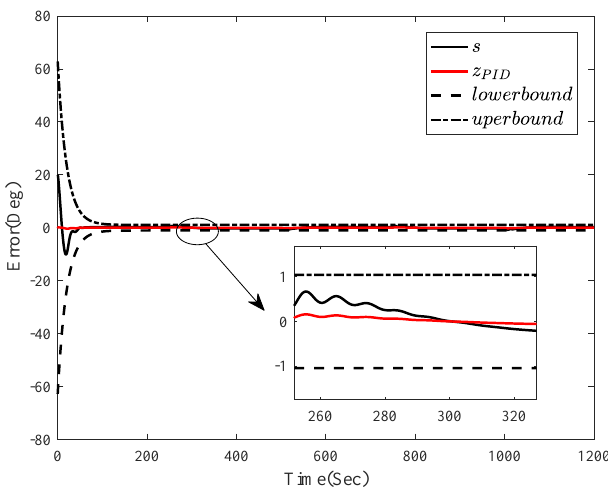
Figure 5. Curves of tracking error and performance boundeds.